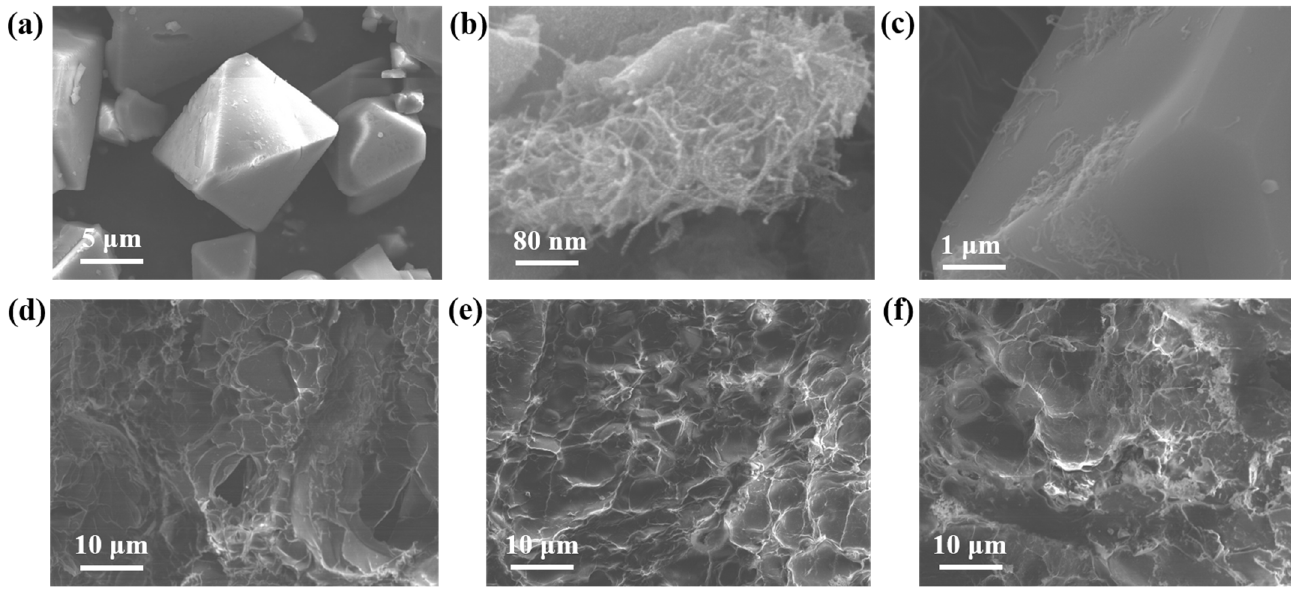
Figure 3. SEM images of different materials: ( a ) Cu-BTC, ( b ) F-CNTs, ( c ) F-C, ( d ) Gel, ( e ) C-G, ( f ) F-C-G.